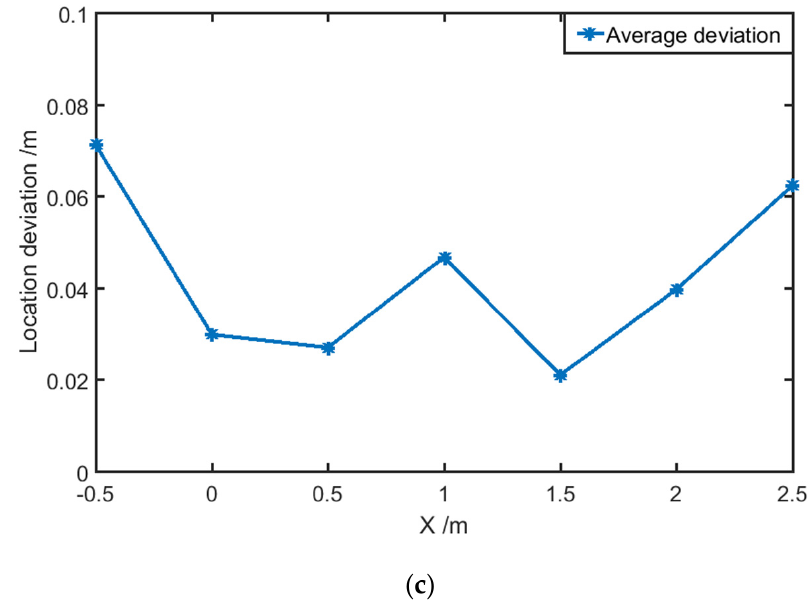
Figure 6. The localization results when the ultrasonic source was positioned at Z = 0.5 m, yet with variable X from − 0.5 m to 2.5 m and Y from 0 m to 2 m. ( a ) The deviation projection in the XY plane; ( b ) The deviation projection in the XZ plane for Y = 1 m; and ( c ) the average localization deviation.